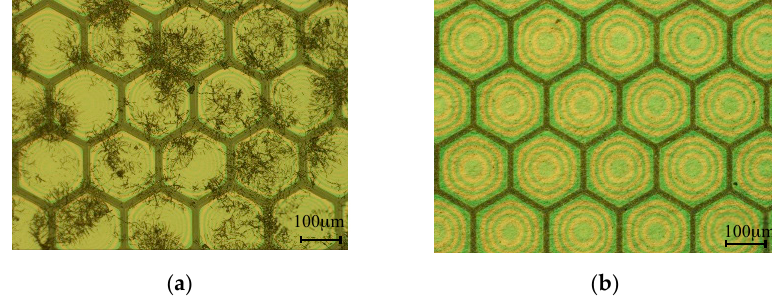
Figure 10. ( a ) Poorly distributed silver nanowire electrode coated on untreated SU-8 membranes; ( b ) Well-distributed and transparent silver nanowire electrode coated on treated SU-8 membranes.